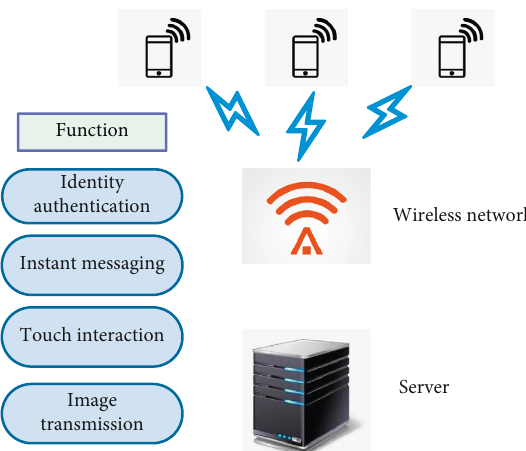
Figure 8: The structure diagram of the client